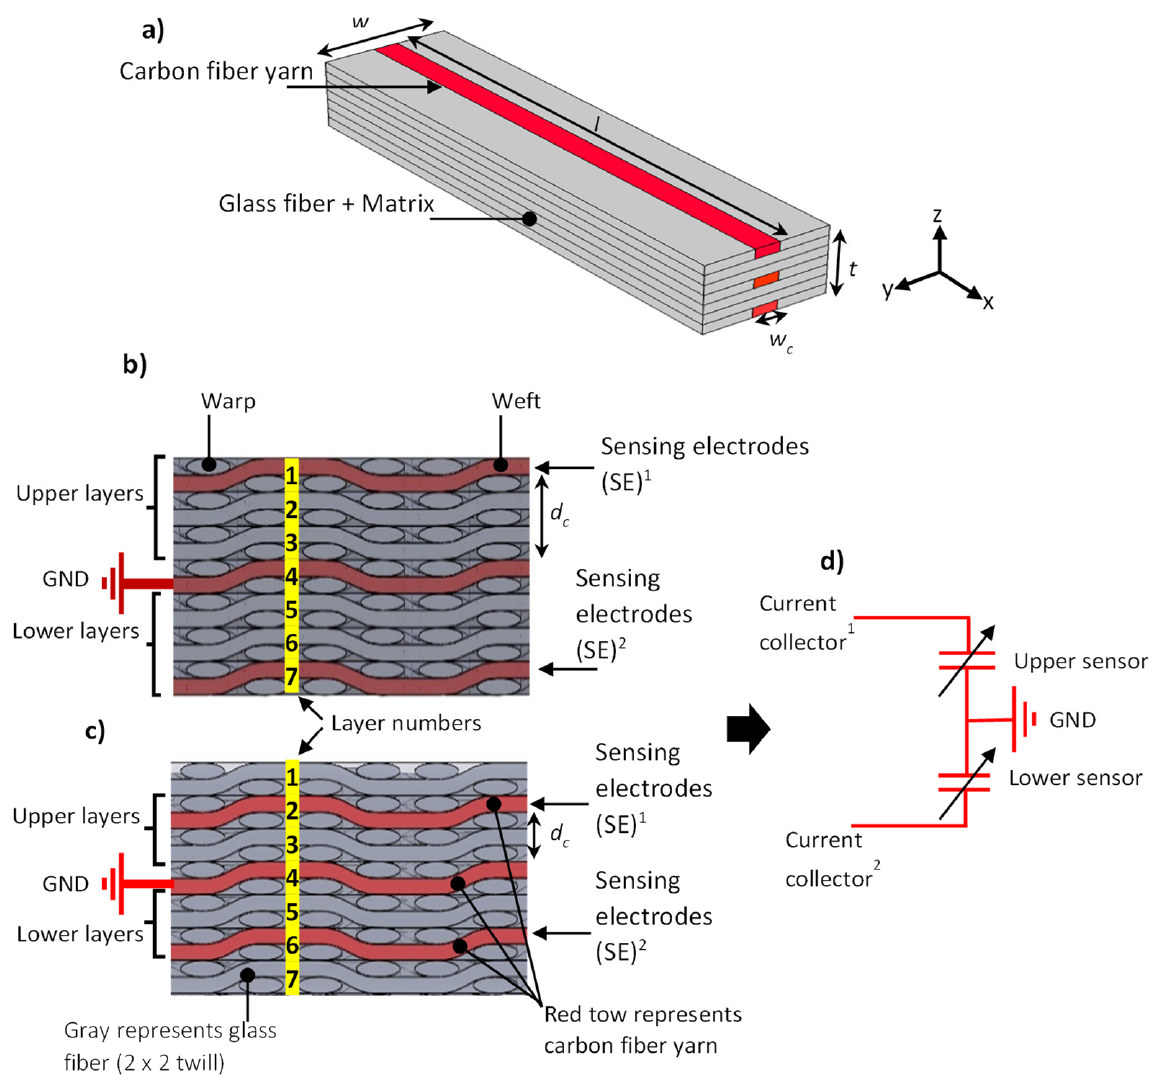
Figure 2. ( a ) Layout of self-sensing intra-ply hybrid composites, ( b , c ) show the sensor configurations for type-A and type-B, ( d ) electrical circuit of the embedded sensor. (SE) 1 and (SE) 2 represent upper layer and lower layer sensing electrodes respectively.